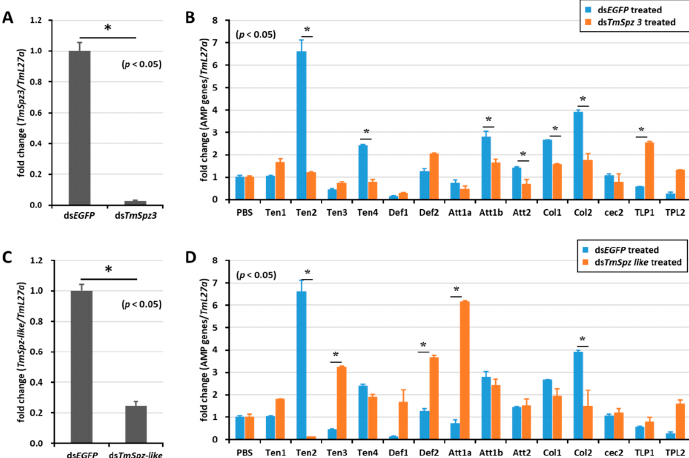
Figure 5. Induction of AMPs after gene silencing of TmSpz-3 and -like and injection of iturin A. The expressions of TmSpz3 ( A ) and TmSpzlike ( C ) were silenced, and iturin A was injected into the gene-silenced larvae. AMP expression was then examined in T. molitor , in the ds TmSpz3 ( B ), and ds TmSpz-like ( D )-injected larvae. The expression of AMPs was quantified by qRT-PCR, using specific primers. * indicates significant difference ( p < 0.05) of AMPs expression, compared to the ds EGFP -injected group.